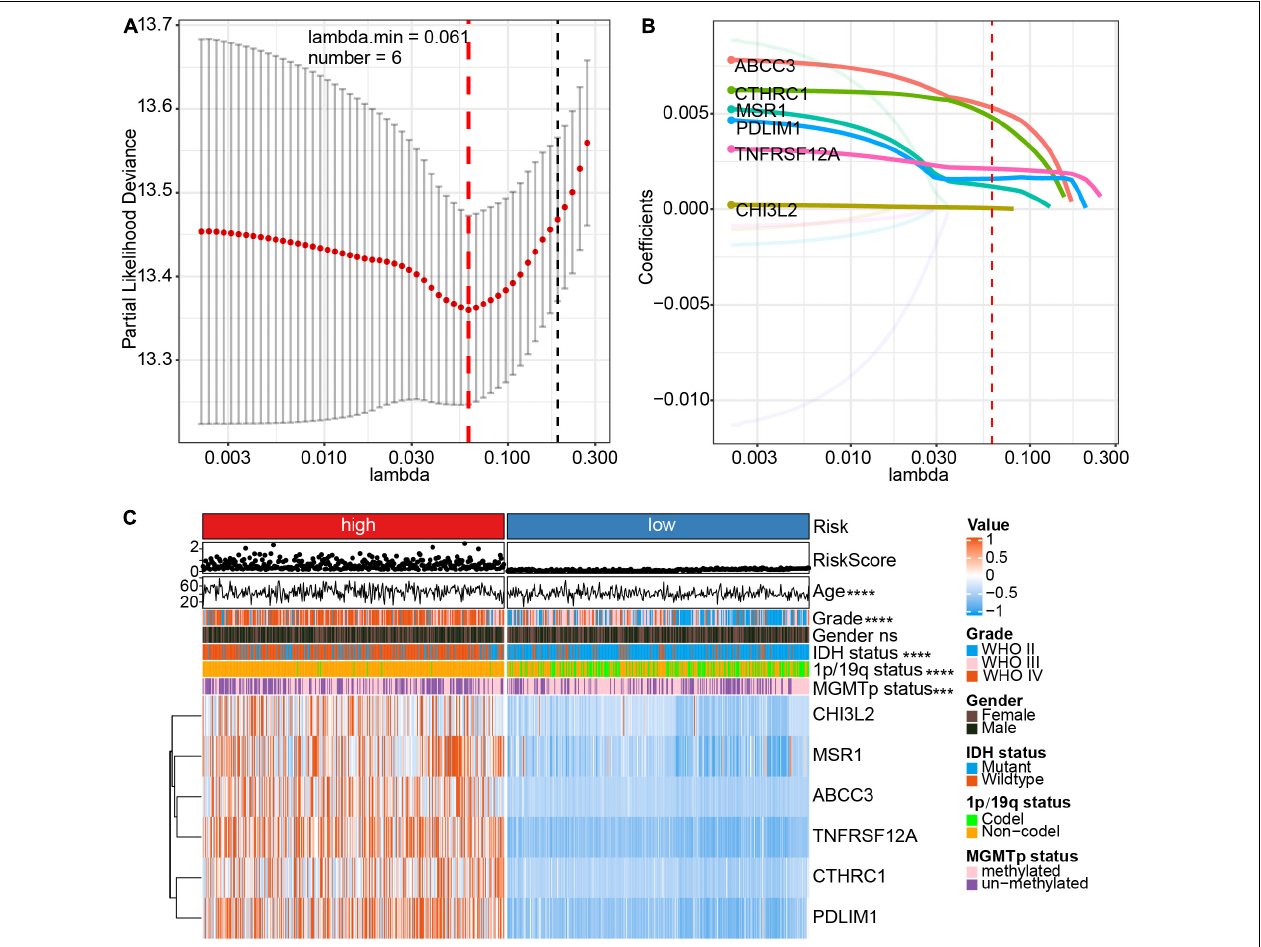
FIGURE 3 | Identification of a CAFs-related six-gene risk signature for overall survival risk characteristics by least absolute shrinkage and selection operator (LASSO) regression analysis in CGGA cohort. (A) Cross-validation for tuning parameter (lambda) screening in the LASSO regression model. (B) LASSO coefficient spectrum of six genes in gliomas. (C) The heatmap shows the association between risk and clinic pathological characteristics of the six-gene risk signature. LASSO, least absolute shrinkage and selection operator. **** P < 0.0001; *** P < 0.001; ns, no